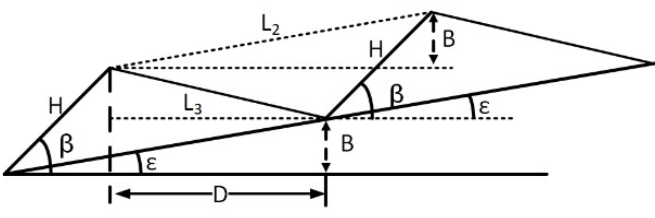
Figure 6. Collector, 𝐻 , deployed on an inclined plane, 𝜀 .